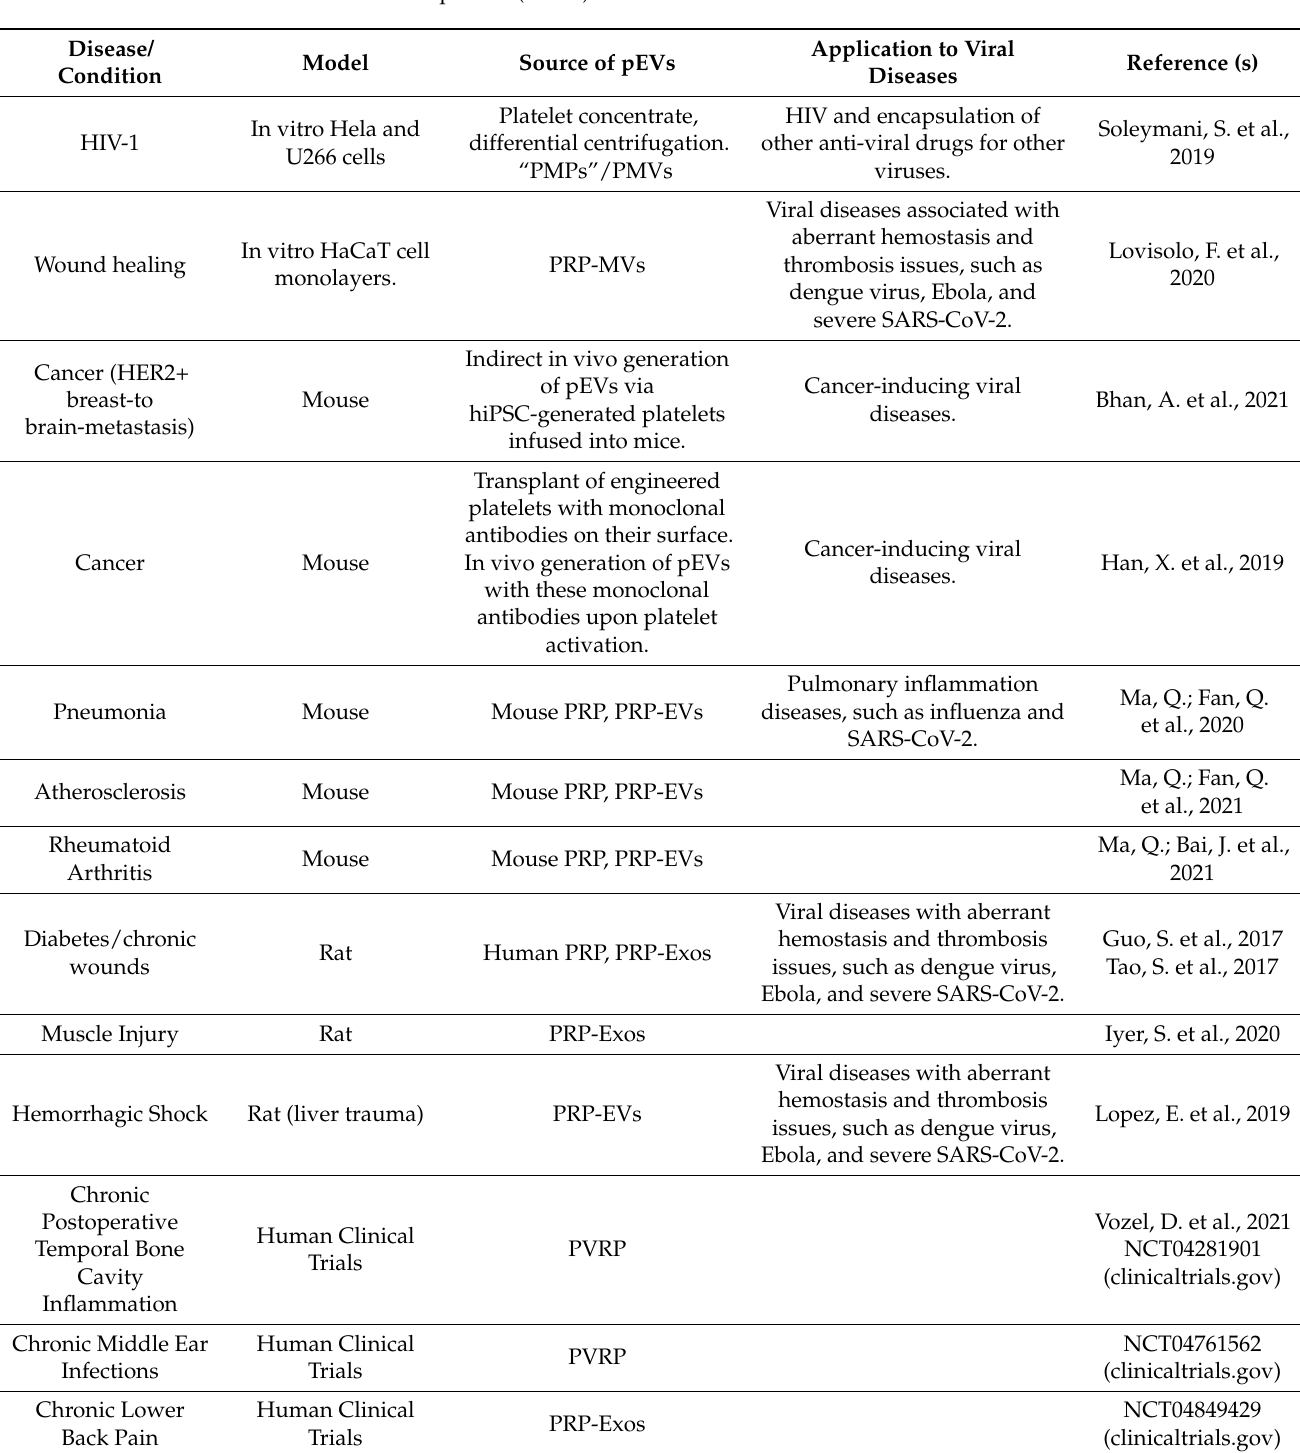
Table 1. Recent experimental pEV therapies for various diseases. Platelet extracellular vesicles (pEVs), platelet microparticles (PMPs), platelet microvesicles (PMVs), human induced pluripotent stem cells (hiPSC), platelet rich plasma (PRP), PRP derived exosomes (PRP-Exos), and platelet and extracellular vesicle rich plasma